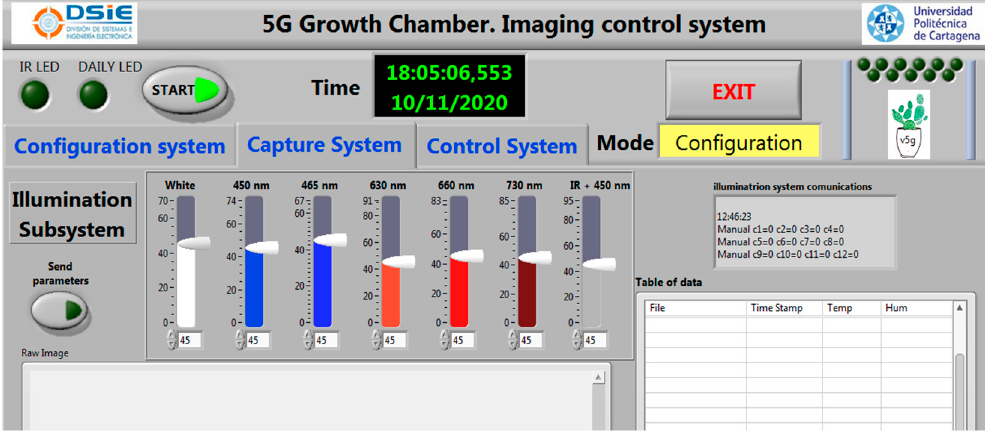
Figure 4. Software interface for configuration and control of the multispectral computer vision system.